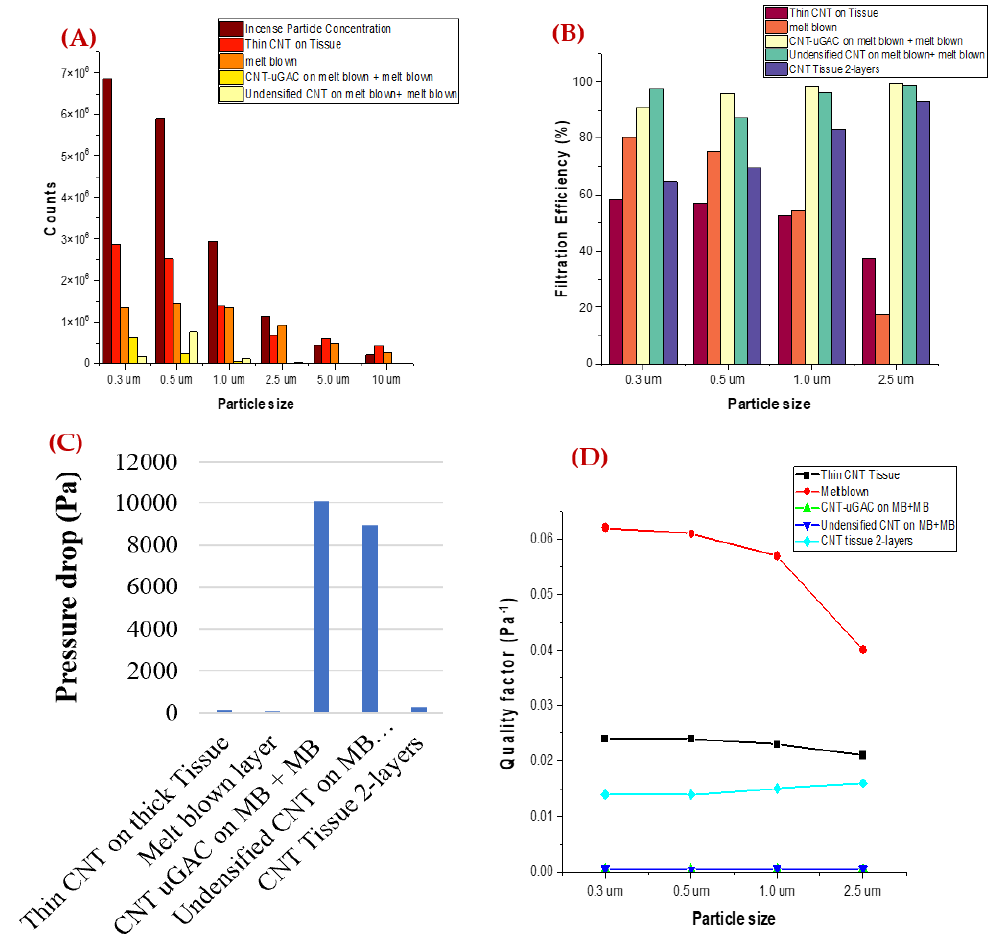
Figure 6. Composite filter performance ( A ) PM concentration, ( B ) Filtration Efficiency, and ( C ) Pres- sure drop of filters, and ( D ) Quality